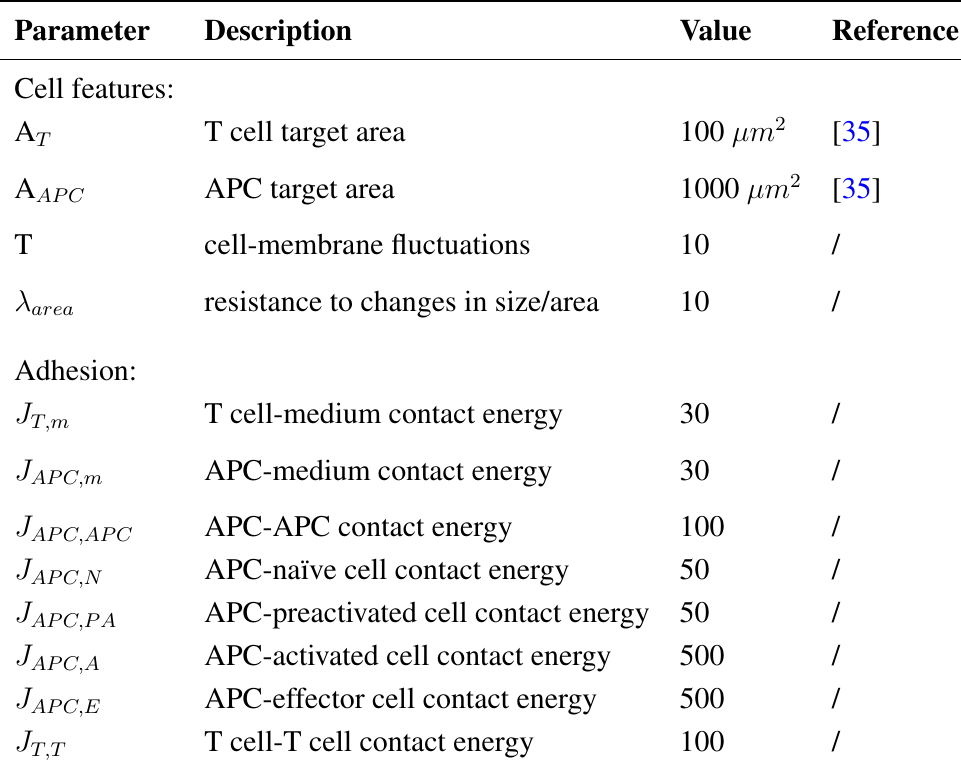
Table 3. Default parameter settings for simulations: cellular level (Potts model)